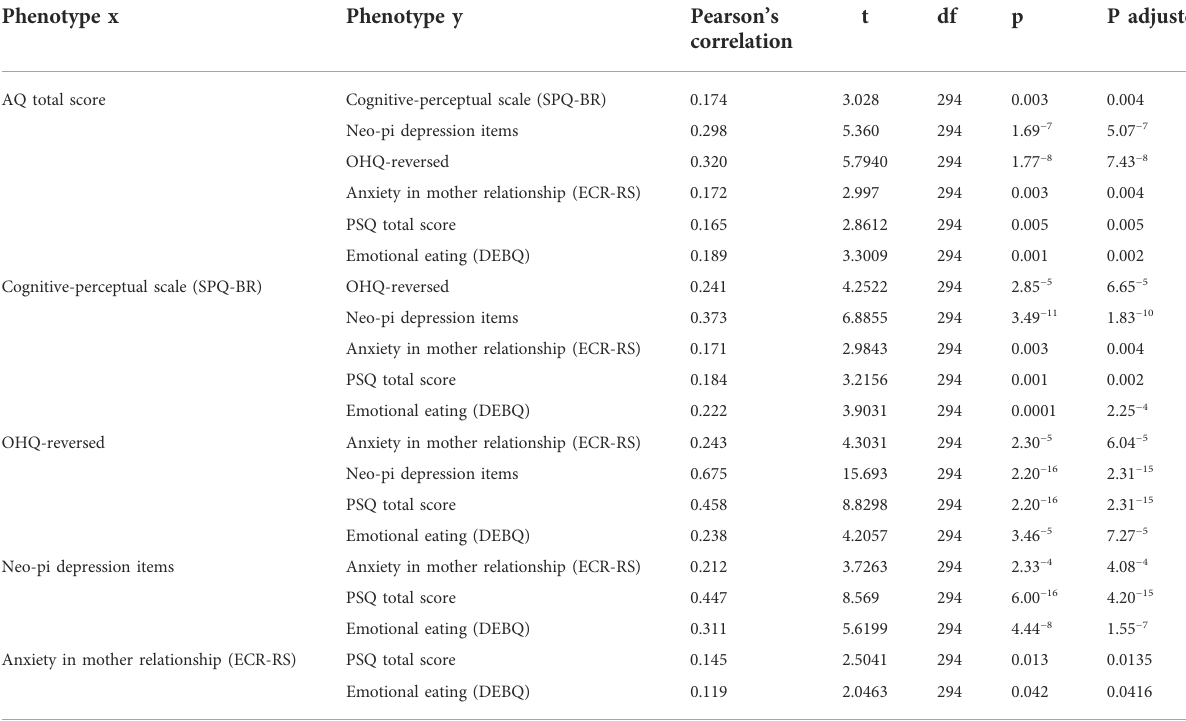
TABLE 1 Pearson moment-product correlations across a of set psychological and behavioral traits deemed to re fl ect typical degrees of variation in phenotypesrelevanttothephenotypeofPrader-Willisyndrome.Correlationsremainedsigni fi cantafterBenjamini-Hochbergcorrectionforfalse discoveries, as shown in the p